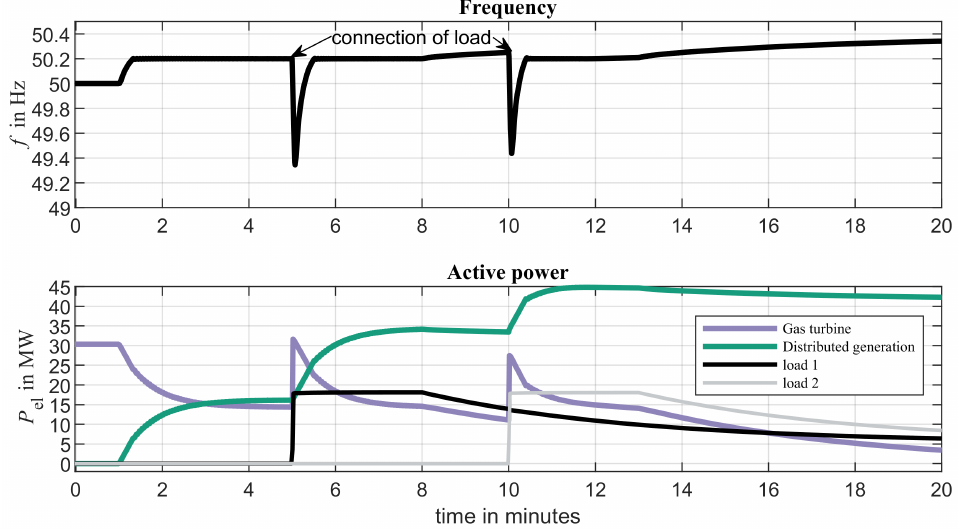
Figure 12. Base case simulation of load connection subject to CLPU ( P 0 = 5MW, a = 2.5, τ = 5min and t d =